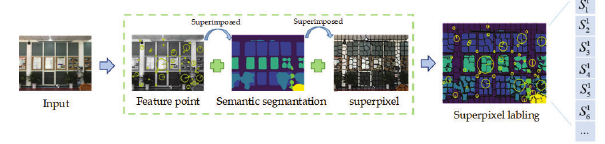
Figure 4. The process of superpixel label